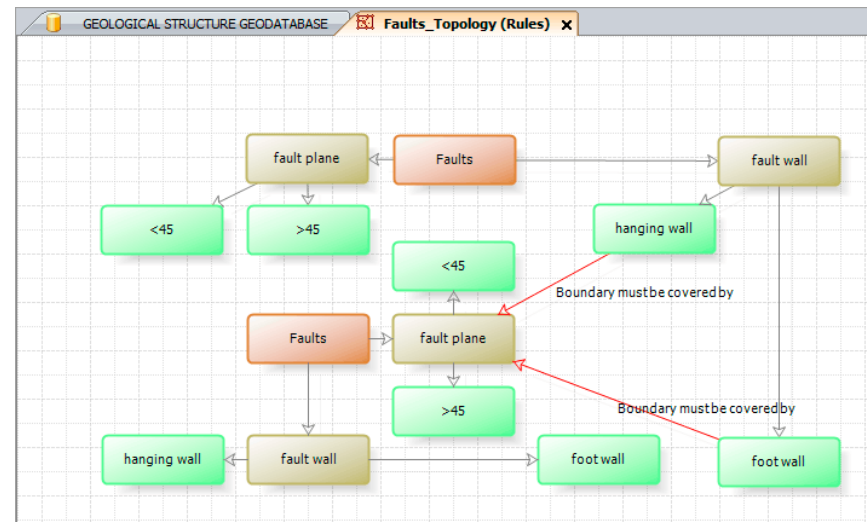
Figure 3. Geodatabase data model of the topology of fault elements.